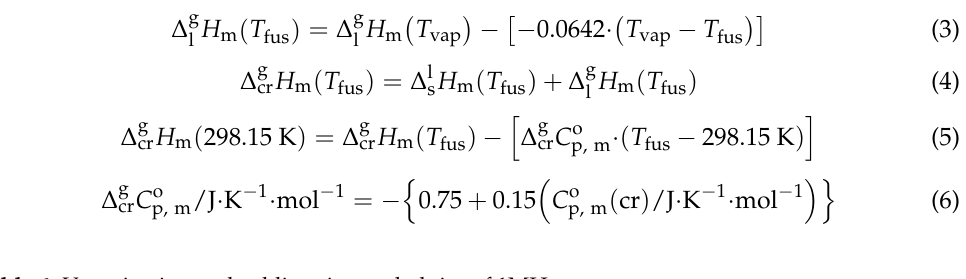
Table 6. Vaporization and sublimation enthalpies of 1MH.